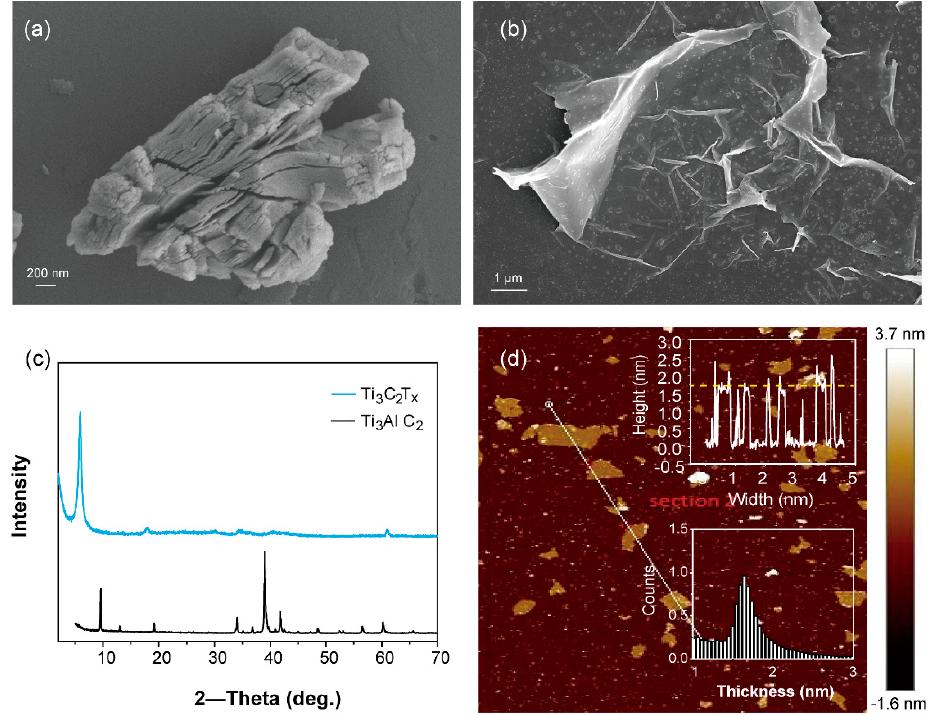
Figure 1. SEM images of ( a ) multilayered Ti 3 C 2 T x before and ( b ) after delamination. ( c ) XRD pattern of Ti 3 AlC 2 and delaminated Ti 3 C 2 T x . ( d ) AFM characterization of delaminated Ti 3 C 2 T x .